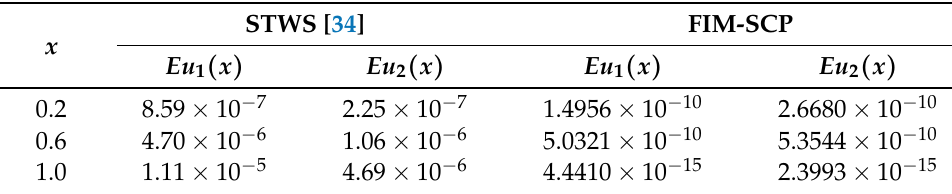
Table 8. A comparison of absolute errors of u 1 ( x ) and u 2 ( x ) for Example 5.